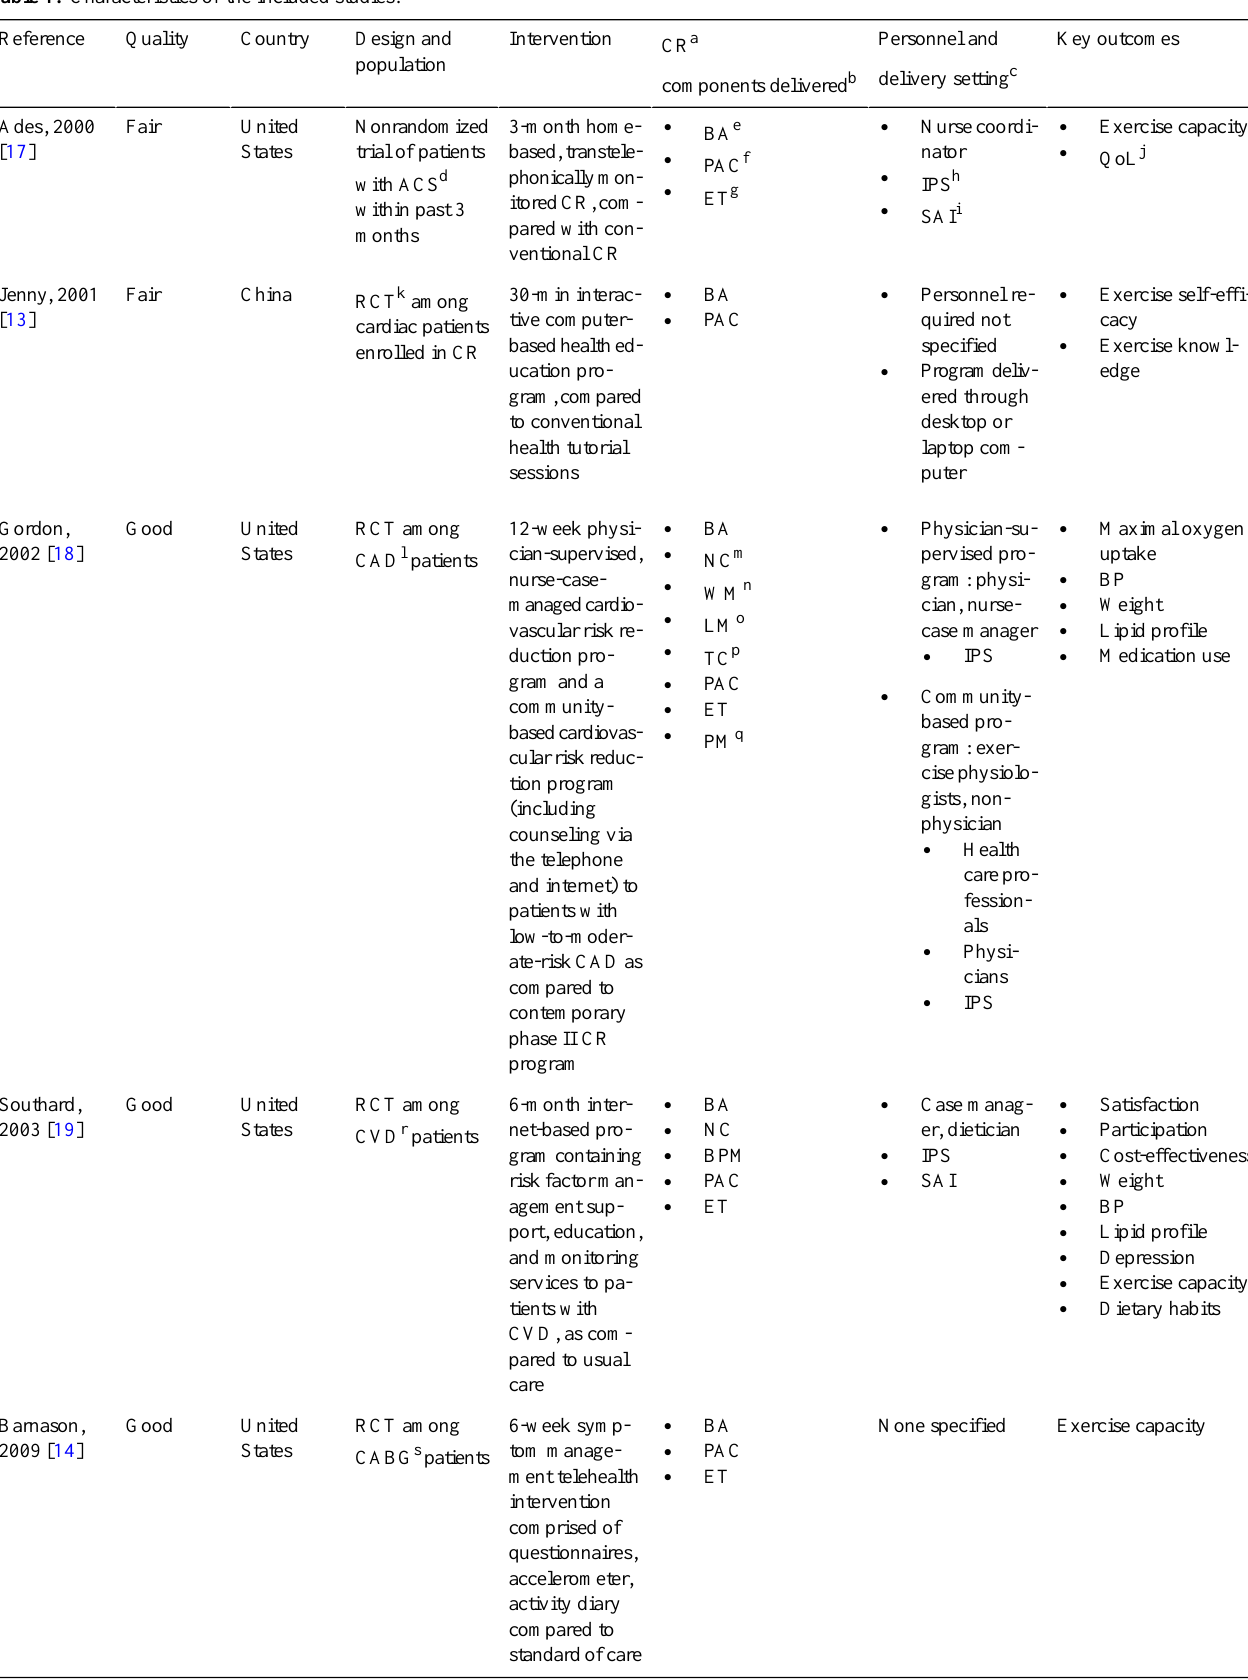
Table 1. Characteristics of the included